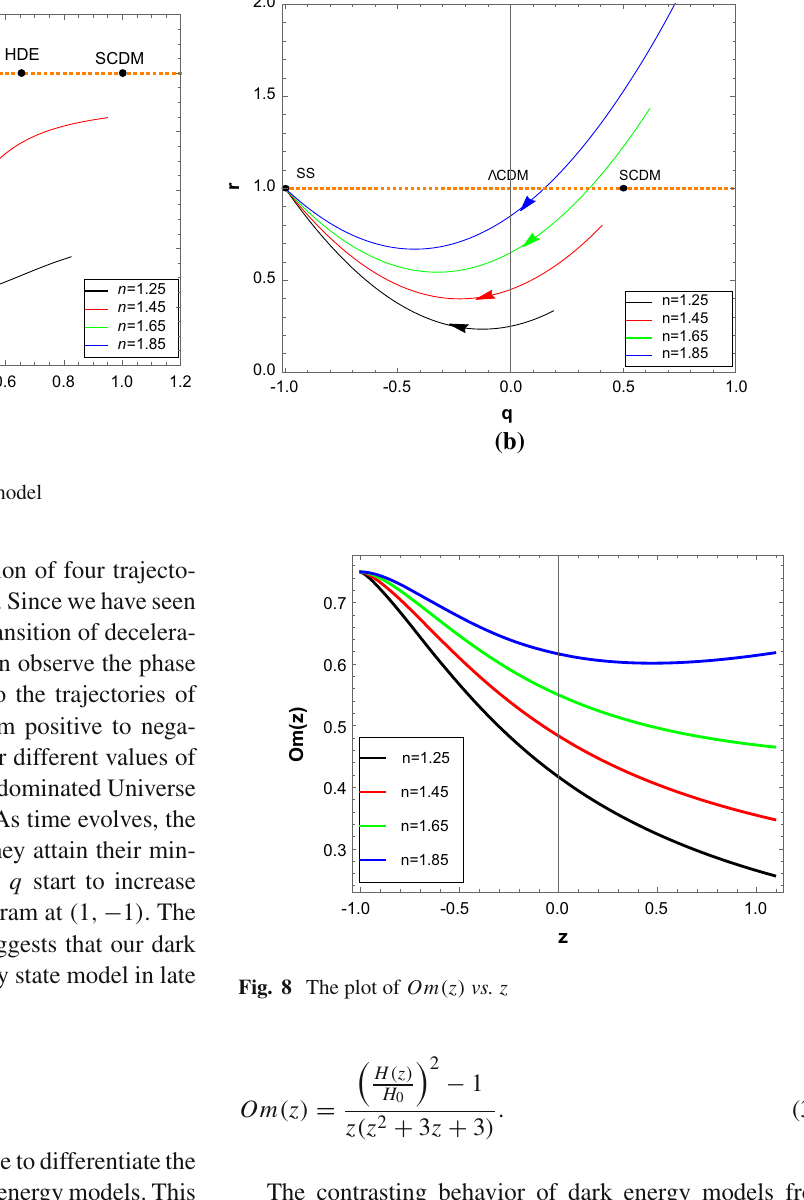
The contrasting behavior of dark energy models from (cid:3) CDM depend on the slope of the Om(z) diagnostic. A quintessence (ω > − 1 ) type behavior of dark energy can be identified by its negative curvature with respect to z , and a phantom type behavior (ω < − 1 ) can be diagnosed by its positive curvature with respect to z , and a zero curvature of Om ( z ) represents the standard (cid:3) CDM. Figure 8 exhibits the evolution of different trajectories of thefunction Om ( z ) withrespect totheredshift z , correspond- ing to different values of the model parameter n . From the plot of Fig. 8, we can observe that all the trajectories show negative slope, i.e., all the trajectories move in an upward direction as time increases or the redshift decreases. The neg- ative curvature pattern suggests that our model is behaving similar to quintessence for all values of n